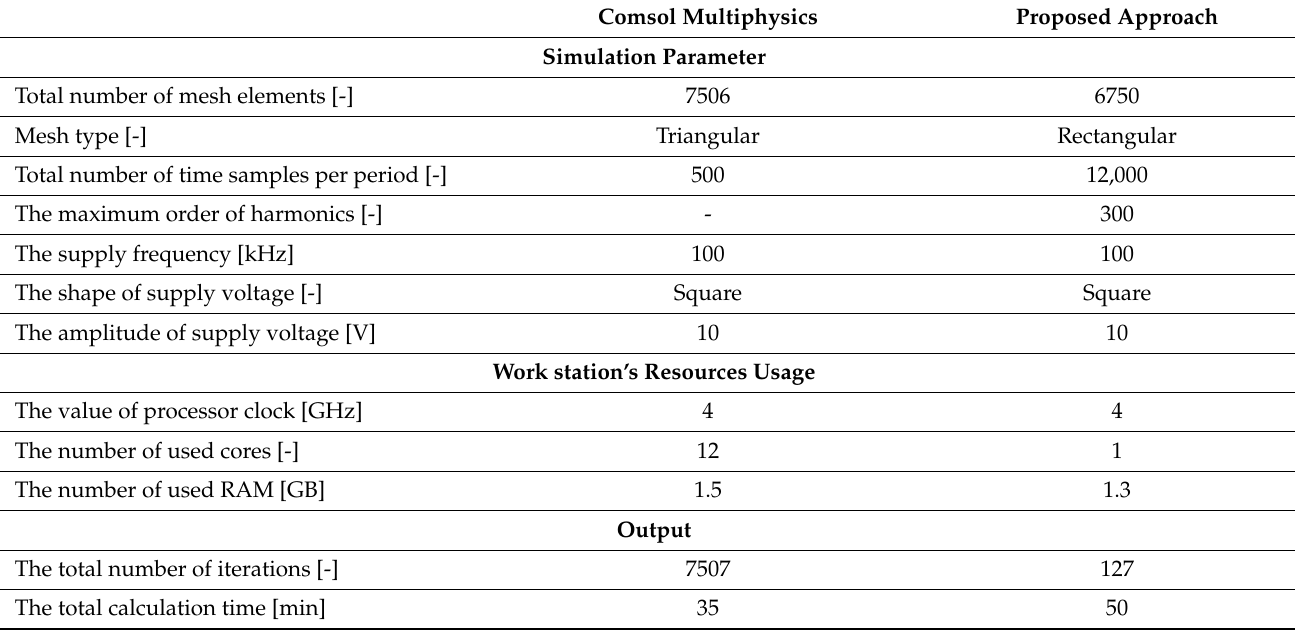
Table 2. The simulations resources’ usage